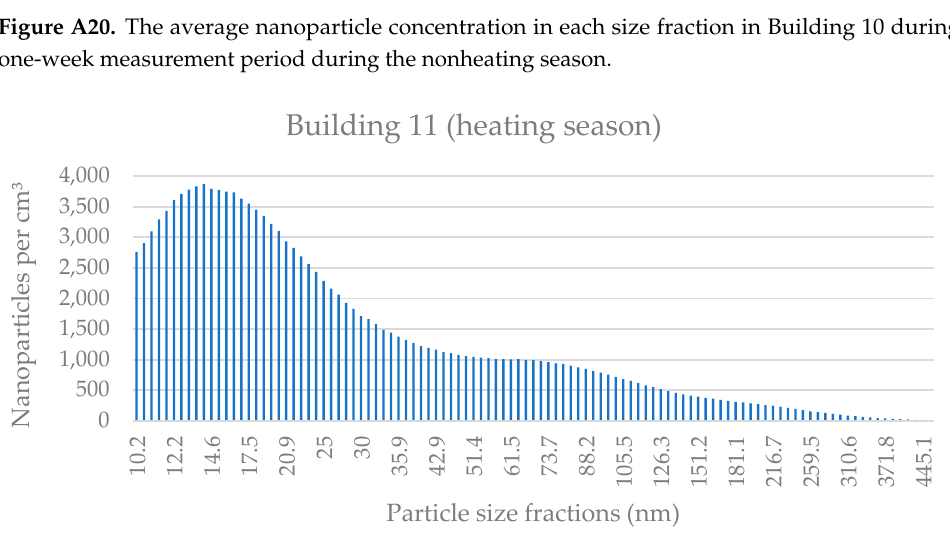
Figure A21. The average nanoparticle concentration in each size fraction in Building 11 during a one-week measurement period during the heating season.